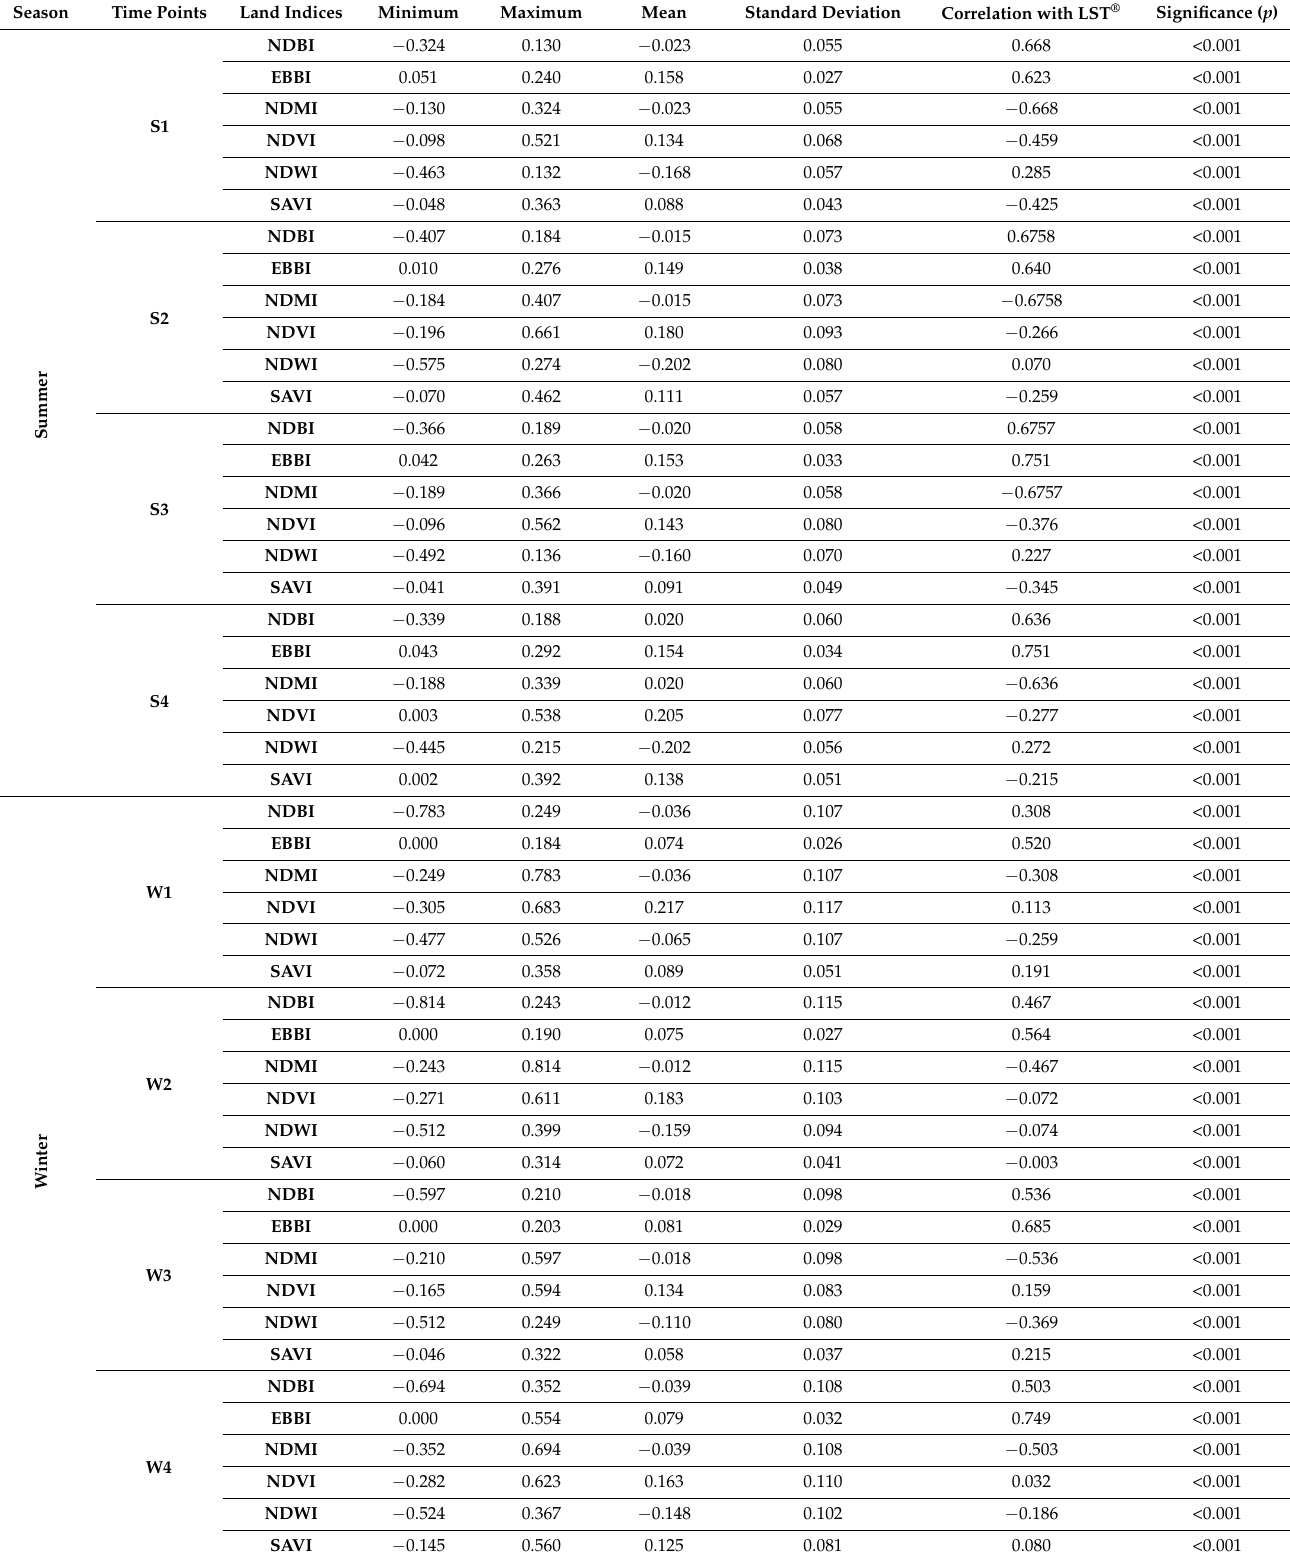
Table 6. Statistics of the six land indices and their relationship with LST for all the summer and winter time